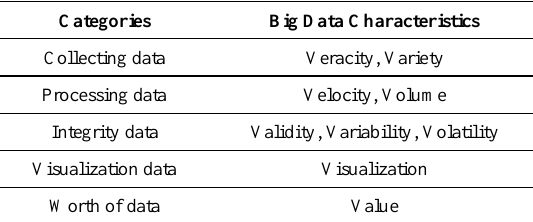
Table 2. Categories of Big Data